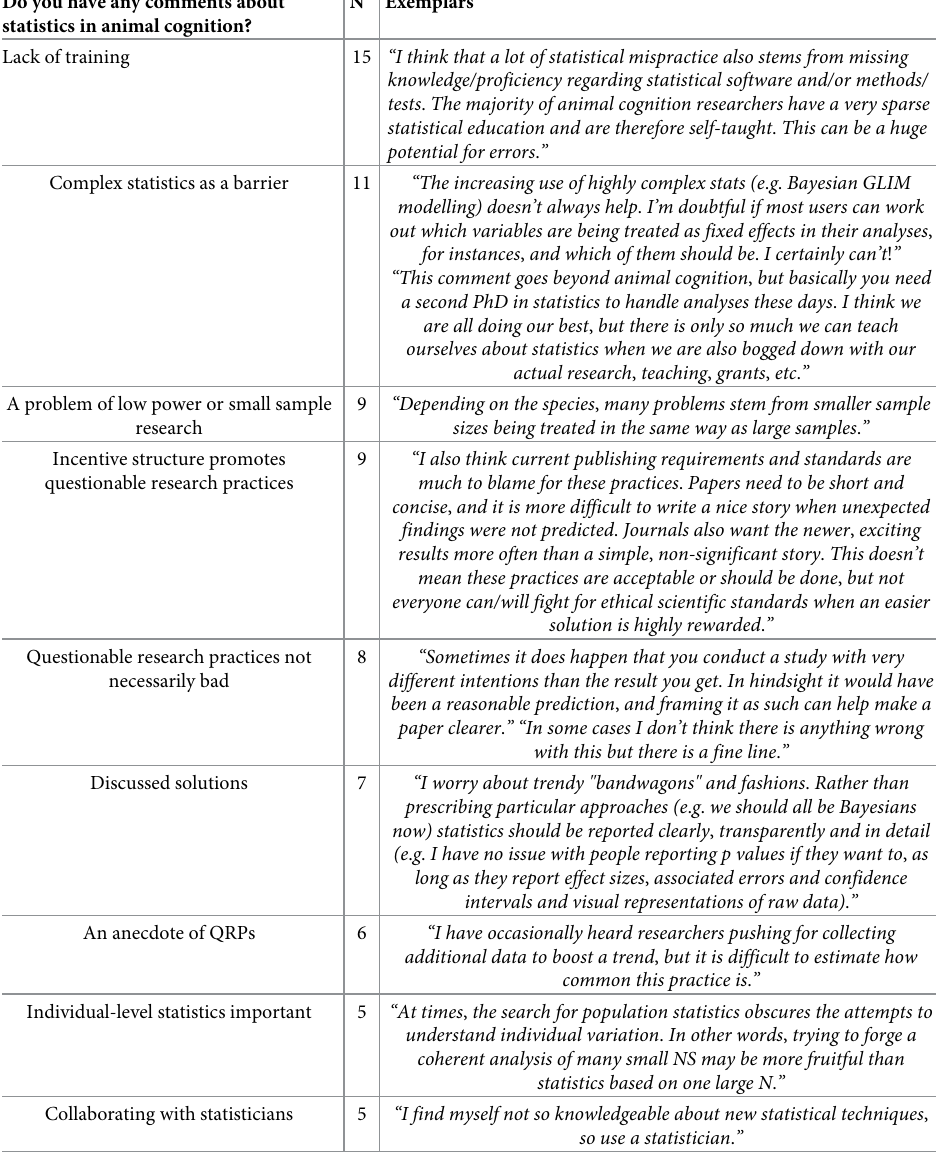
Table 6. Animal cognition researchers’ comments about the use of statistics in the